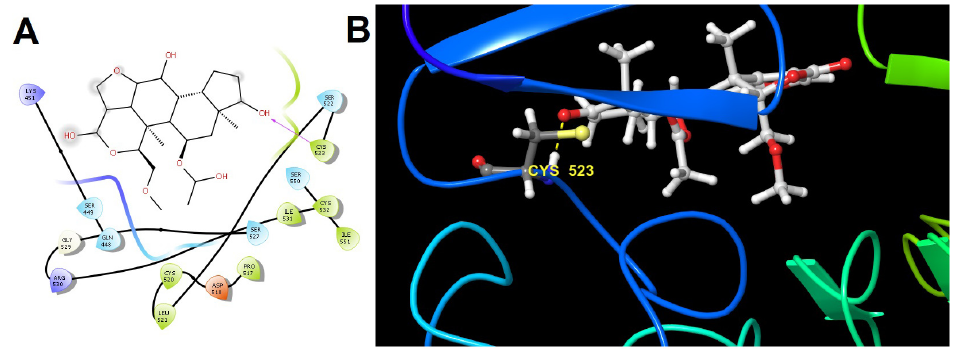
Figure 8. Molecular interactions of Wortmannin within the catalytic pocket residues of receptor ERBB4. ( A ) Two dimensional (hydrogen bond formation between Cys523 residue of ERBB4 and OH atom of Wortmannin showed in magenta line) and ( B ) three-dimensional interaction (hydrogen bond formation between Cys523 residue of protein-ligand complex showed in yellow color dotted